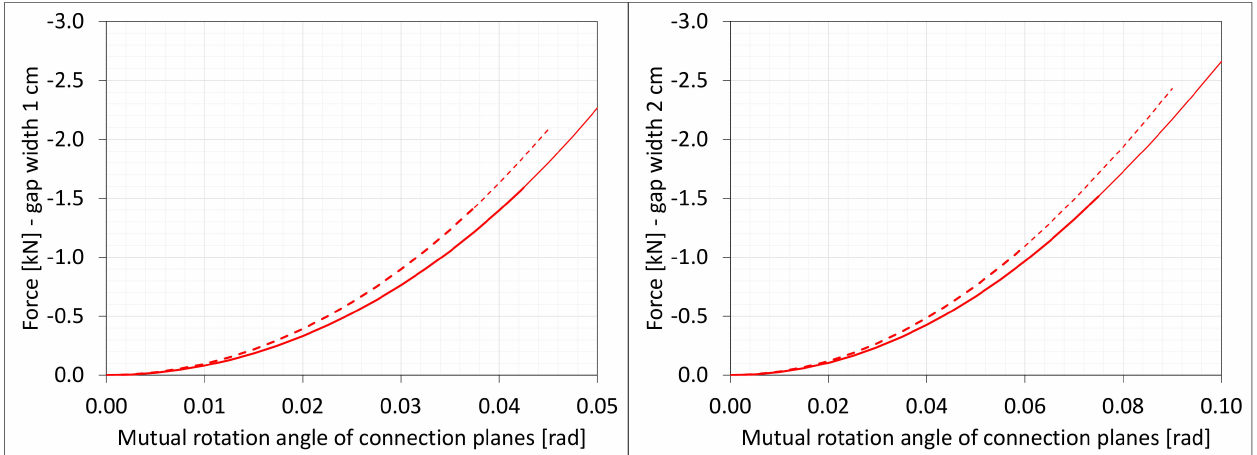
Figure 26. Equilibrium paths for axial force N z . The width of the gap is equal to 1.0 cm, left graphic, and 2.0 cm, right graphic. Plane strain models, solid lines; and 3D models, dashed lines (curves from Figure 11). Parts of charts with non-physical deformations are displayed with thin